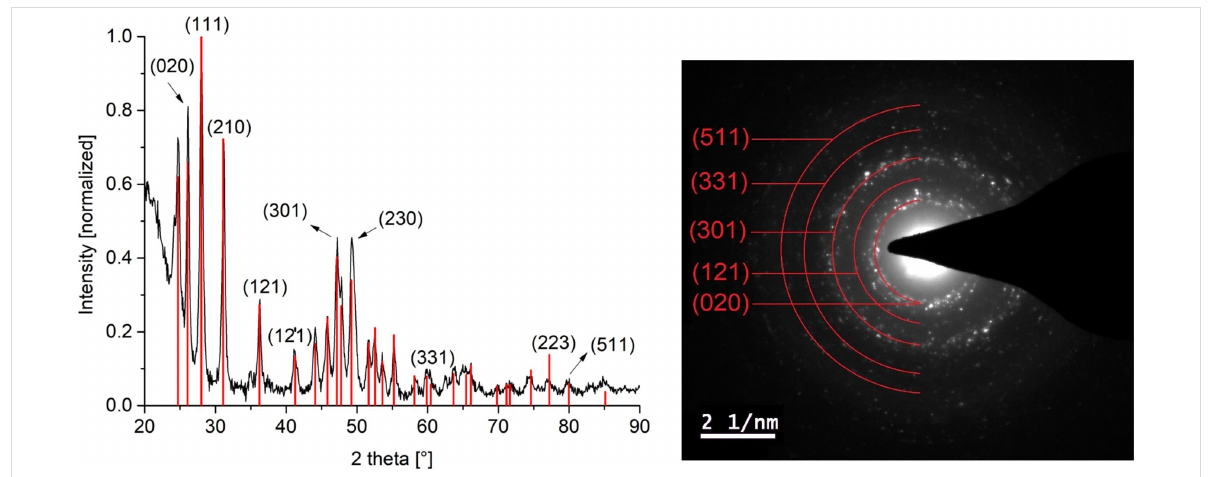
Figure 2: PXRD and SAED (ErF 3 reference peaks in red from COD 4030804, orthorhombic structure with space group Pnma ) of 1.0 wt % ErF 3 -NPs in [BMIm][BF 4 ] from Er(amd) 3 .